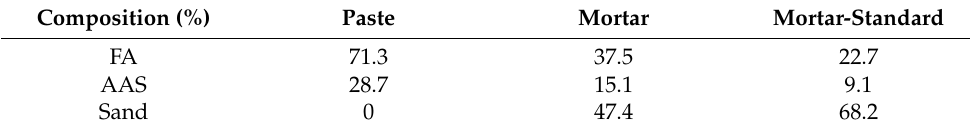
Table 4. Mix summary the proportion of the geopolymer